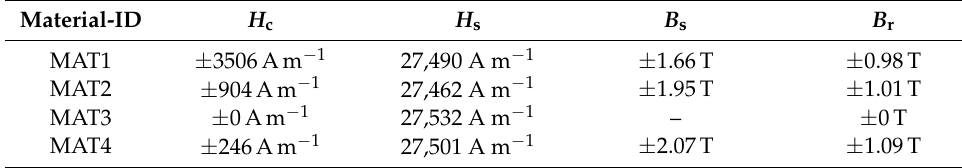
Table 7. Characteristic values of the hysteresis loops of the investigated